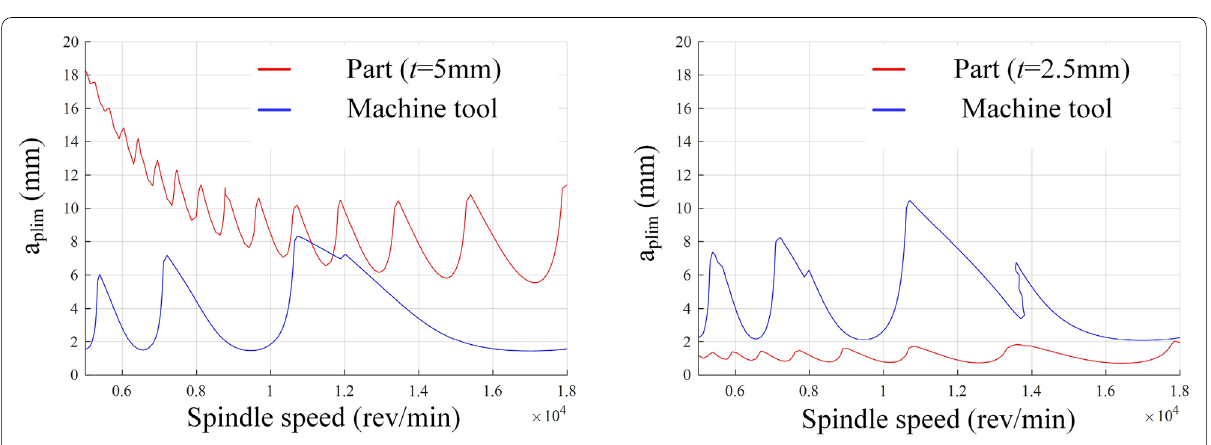
Figure 8 Stability curves of machine tool and part in critical thicknesses